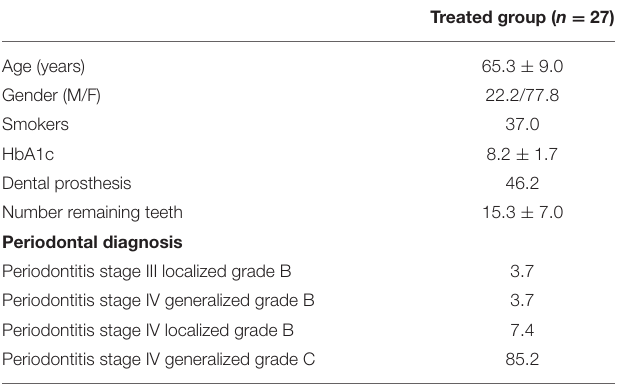
TABLE 1 | Baseline data of treated patients, prior pandemic.